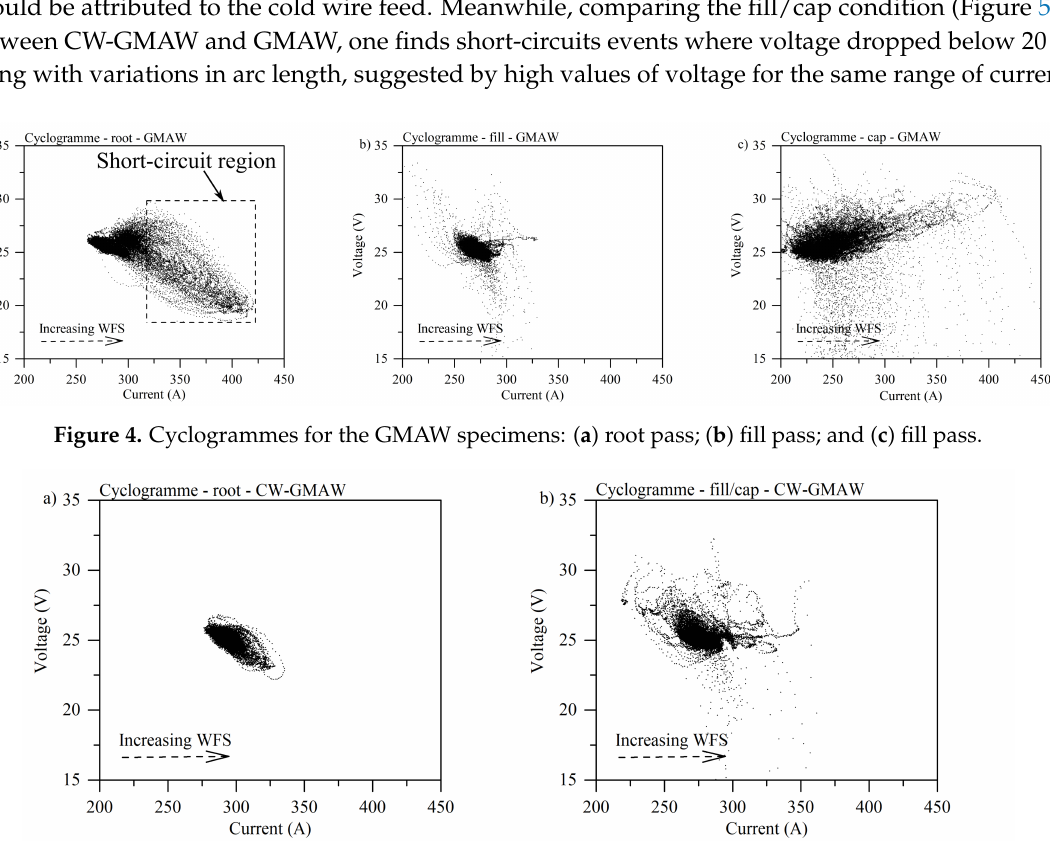
Figure 5. Cyclogrammes for the GMAW specimens: ( a ) root pass; ( b ) fill pass; and ( c ) fill